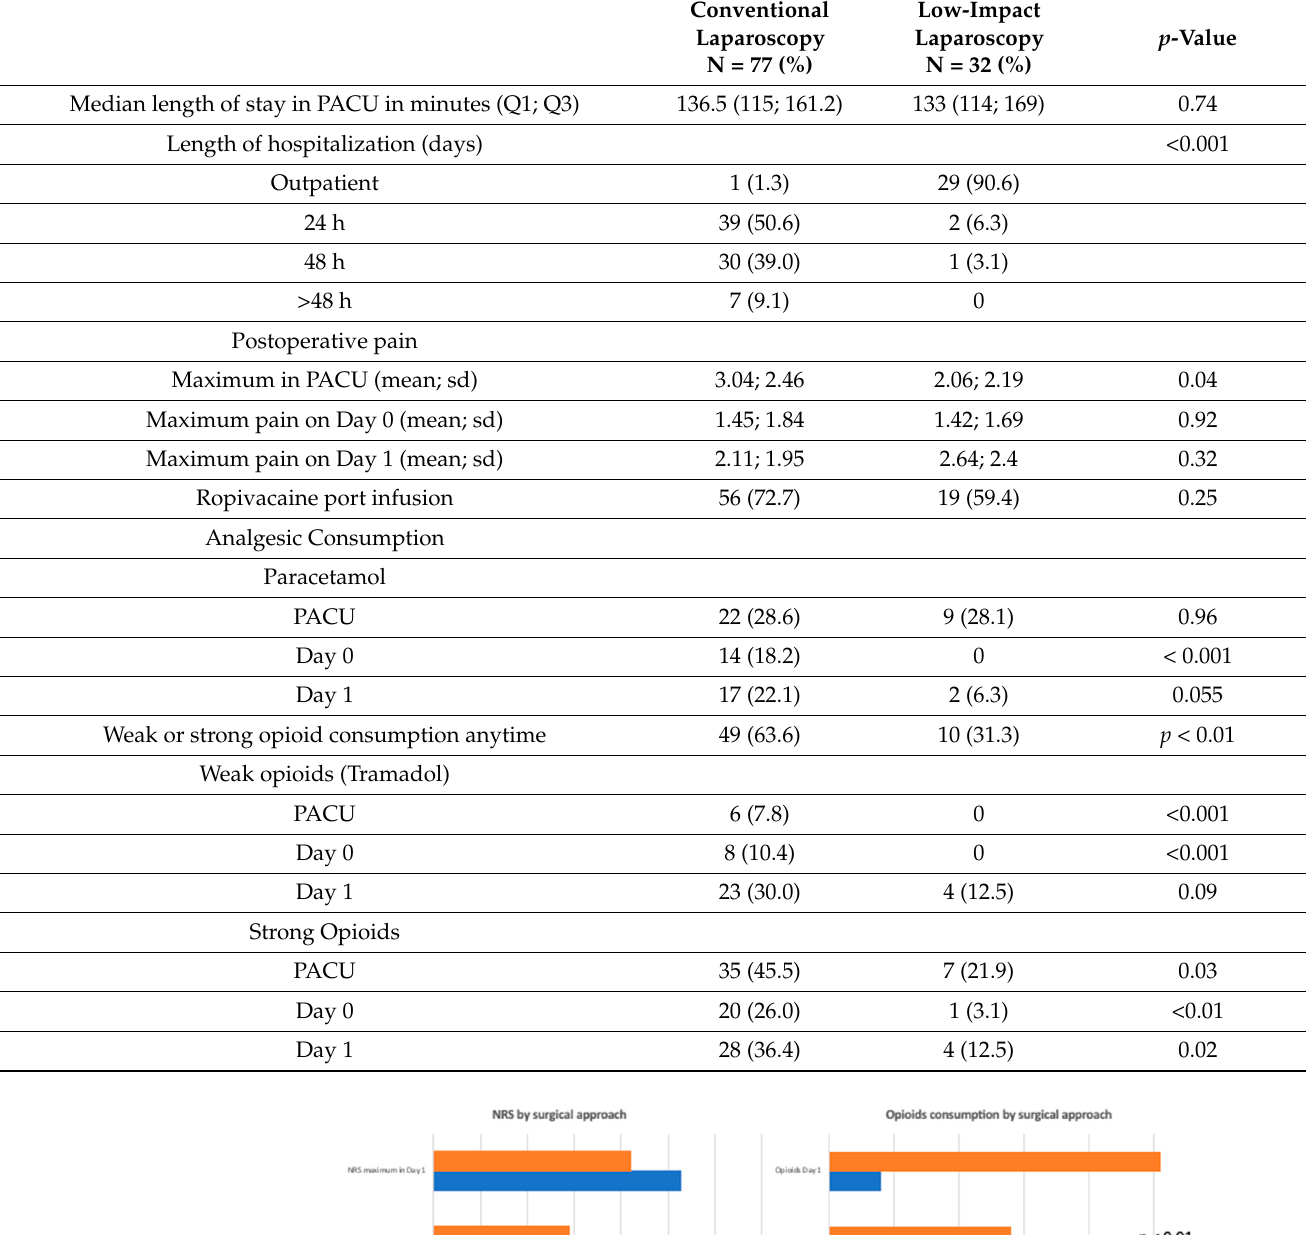
Table 3. Postoperative outcomes and pain.